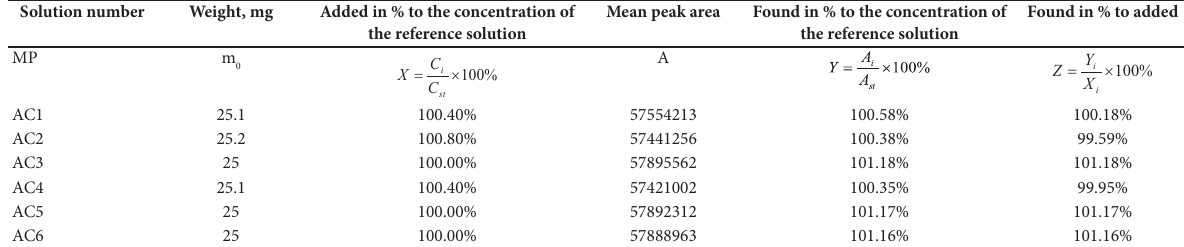
Table 7. Intra-laboratory precision (first